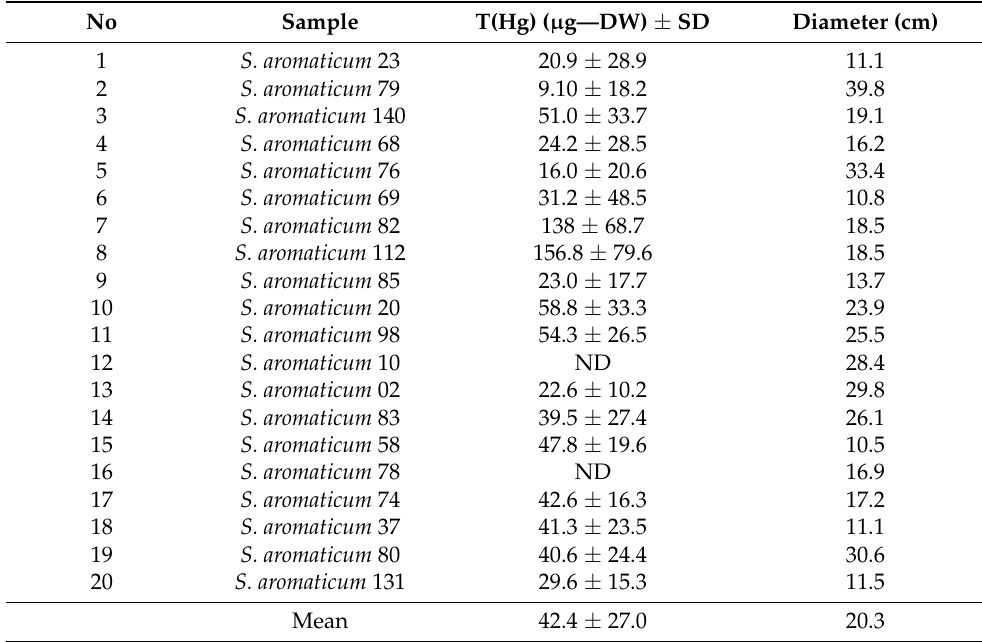
Table 2. Total weight of Hg (THg) in the bark and diameter of Syzygium aromaticum .